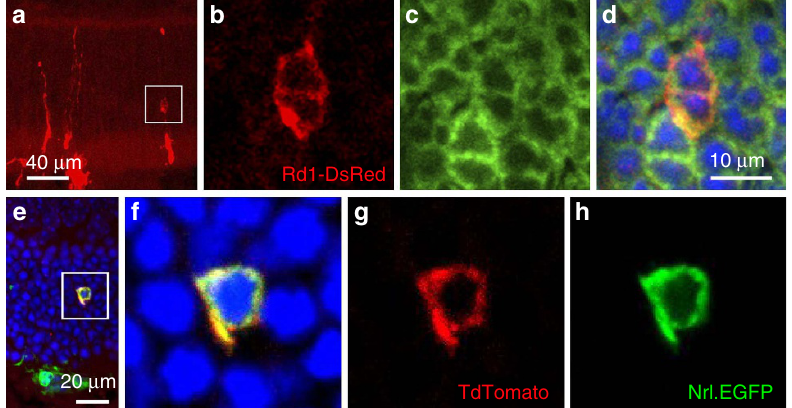
Figure 3 | Further evidence of cytoplasmic transfer between donor and host. ( a – d ) Donor cells collected from P1–3 DsRed mice, which were also homozygous for the rd1 mutation were transplanted into adult Nrl-GFP mice in which rods are labelled with GFP. Three weeks after transplantation, a DsRed and GFP-positive photoreceptor cell bodies were seen. ( e – h ) To confirm cytoplasmic transfer of proteins using a Cre-lox recombination, donor cells ( CAG-LSL-tdTomato , Nrl-GFP ) at P7 were transplanted into adult Crx-Cre host mice. Three days post transplantation, donor cells in the subretinal space are GFP positive as expected, whereas in the host ONL (white box) a double-labelled (GFP and tdTomato) cell body is visible, confirming that Cre had passed from host photoreceptor to donor cell to activate tdTomato, which then retrogradely labelled the host photoreceptor together with